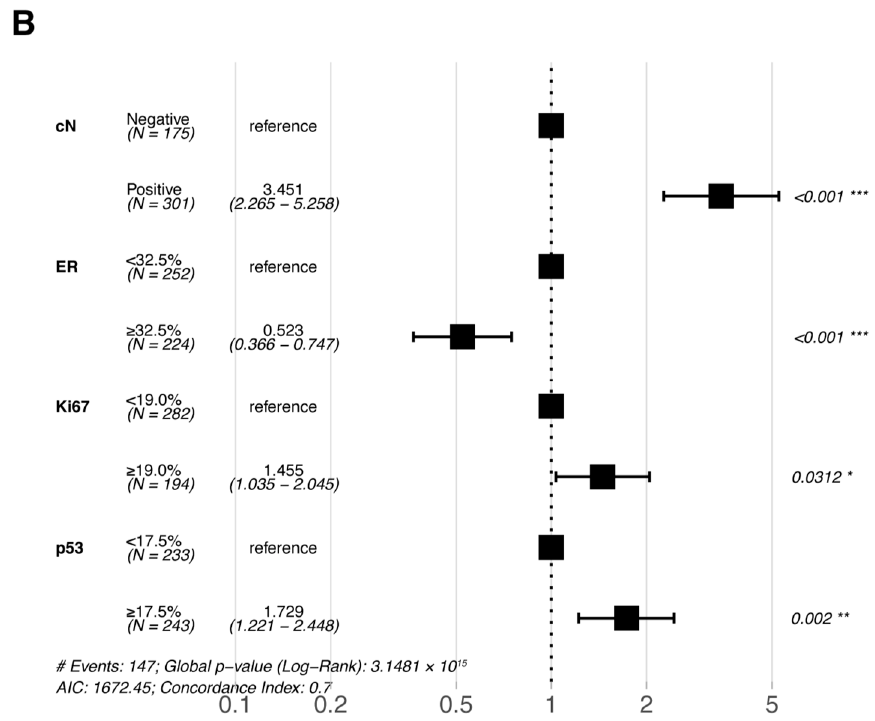
Figure 3. Forest plots of the multivariate analysis of DFS in the primary cohort based on ( A ) pre- NAC core needle biopsy and ( B ) post-NAC surgical specimens. * p < 0.05; ** p < 0.01; *** p < 0.001. Abbreviations: DFS, disease-free survival; pCR, pathologic complete response; NAC, neoadjuvant chemotherapy; cN, clinical nodal; ER, estrogen receptor.